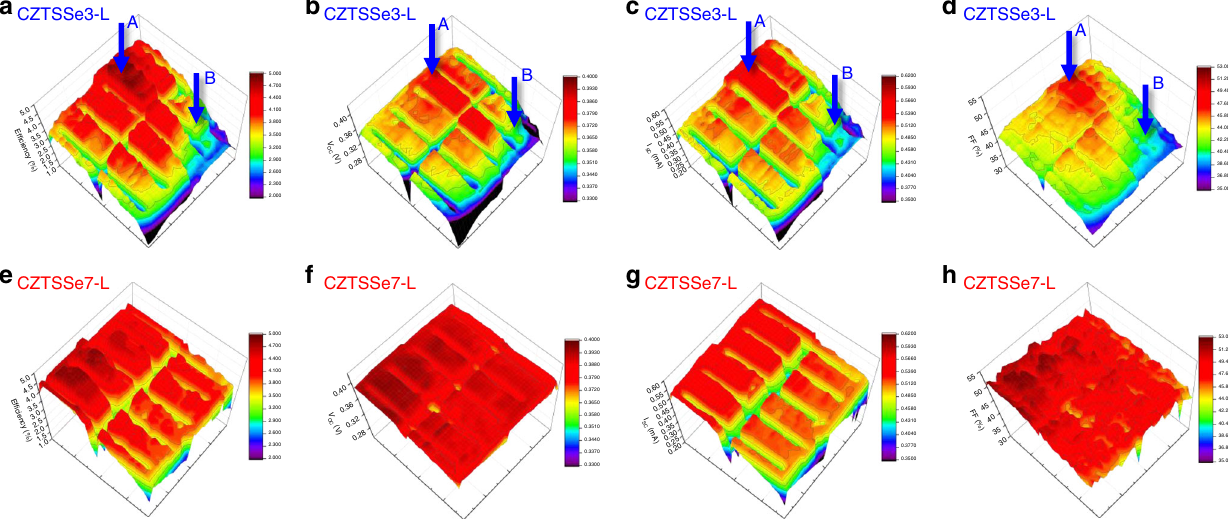
Fig. 4 Within-cell uniformity of photovoltaic device properties by micro current-voltage (MIV). a Ef fi ciency, b V OC , c I SC , and d FF of CZTSSe3-L with a 2.242cm 2 designated cell area (Supplementary Fig. 7m). e Ef fi ciency, f V OC , g I SC , and h FF of CZTSSe7-L with a 2.214 cm 2 designated cell area (Supplementary Fig.